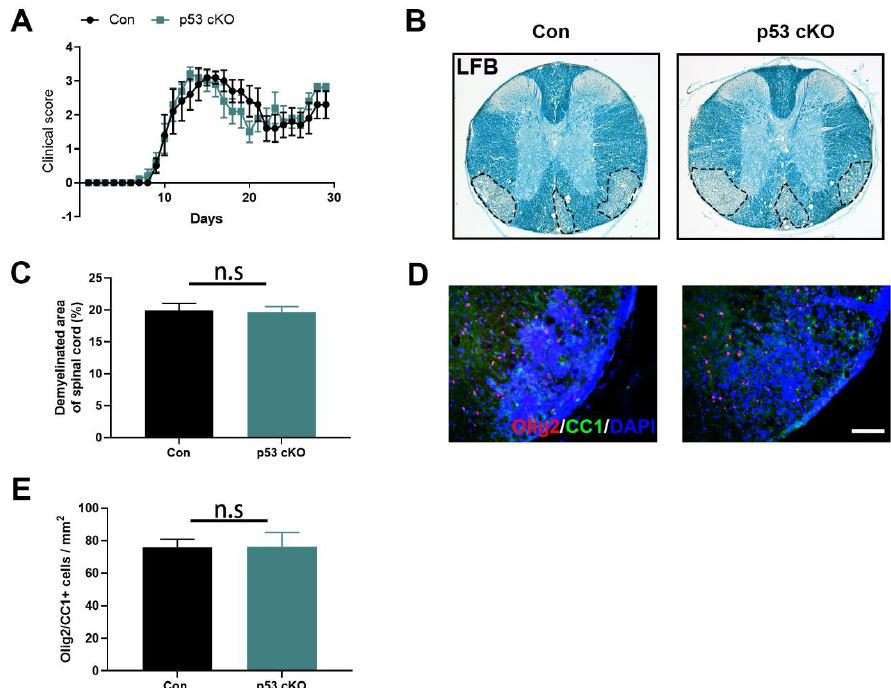
Figure 2. p53 deletion in OLs did not alter EAE severity. ( A ). Clinical score measurements showed no difference in the development of EAE and disease severity between Con and p53 cKO mice. ( B , C ). Luxol fast blue (LFB) staining of myelin showed no difference in the demyelination lesions at 30 days post EAE induction between Con and p53 cKO mice. Dashed lines demarcate lesion areas. ( D , E ). Representative immunohistochemistry images of olig2 and CC1 and their quantification of Olig2/CC1+ cells showed no difference in the number of OLs in the spinal cord at 30 days post EAE induction between Con and p53 cKO mice. ( A ): n = 6 mice for Con, n = 6 mice for p53 cKO, two-way ANOVA test; ( C , E ): n = 3 mice/group, two-tailed unpaired Student’s t -test. The data are presented as mean ± sem. n.s: no significance. ( D ): Scale bar = 100 μ m. ( B ): Dotted lines demarcate lesion areas.